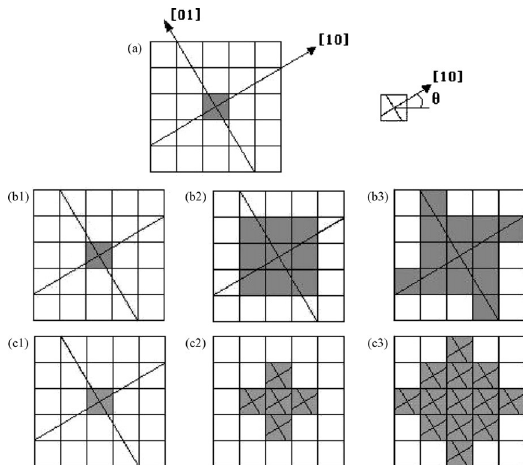
Figure 6. Schematics for the growth of a nucleus, whose crystallographic direction has a divergence angle with respect to the cellular-automata (CA) lattice, as presented by Zhan et al. [57]: ( a ) the crystallographic orientation of the nucleus; ( b ) expected growth process; ( c ) actual growth